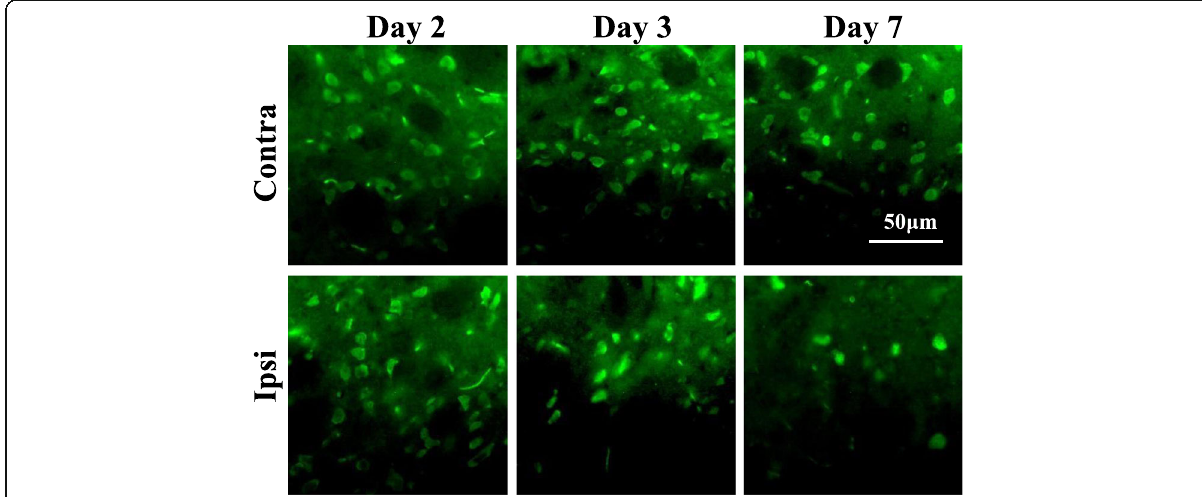
Fig. 4 Typical NeuN immunostaining images in the dorsal striatum after mild focal ischemia. The upper panels are the images of contralateral side striatum, and the bottom panels are the images of ipsilateral side striatum at 2, 3, and 7 days after 20-min middle cerebral artery occlusion (MCAO). Scale bar, 50 μ m. Contra, contralateral side; Ipsi, ipsilateral